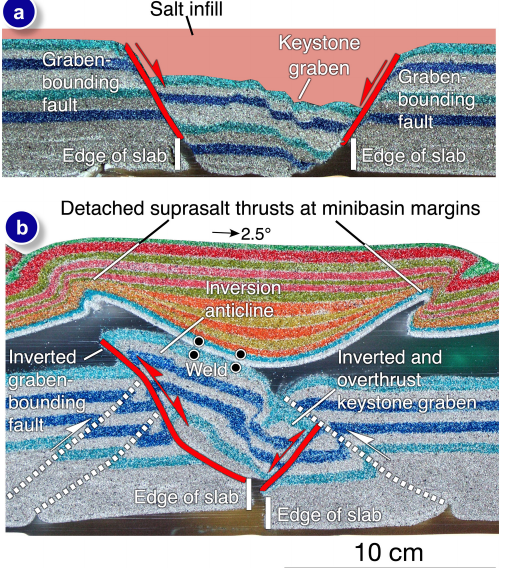
Figure 14. Detailed views (a–c) of sections through Model 1 illus- trating the evolution of an S structure. Figure 15. (a) Detailed view of a non-inverted subsalt graben from